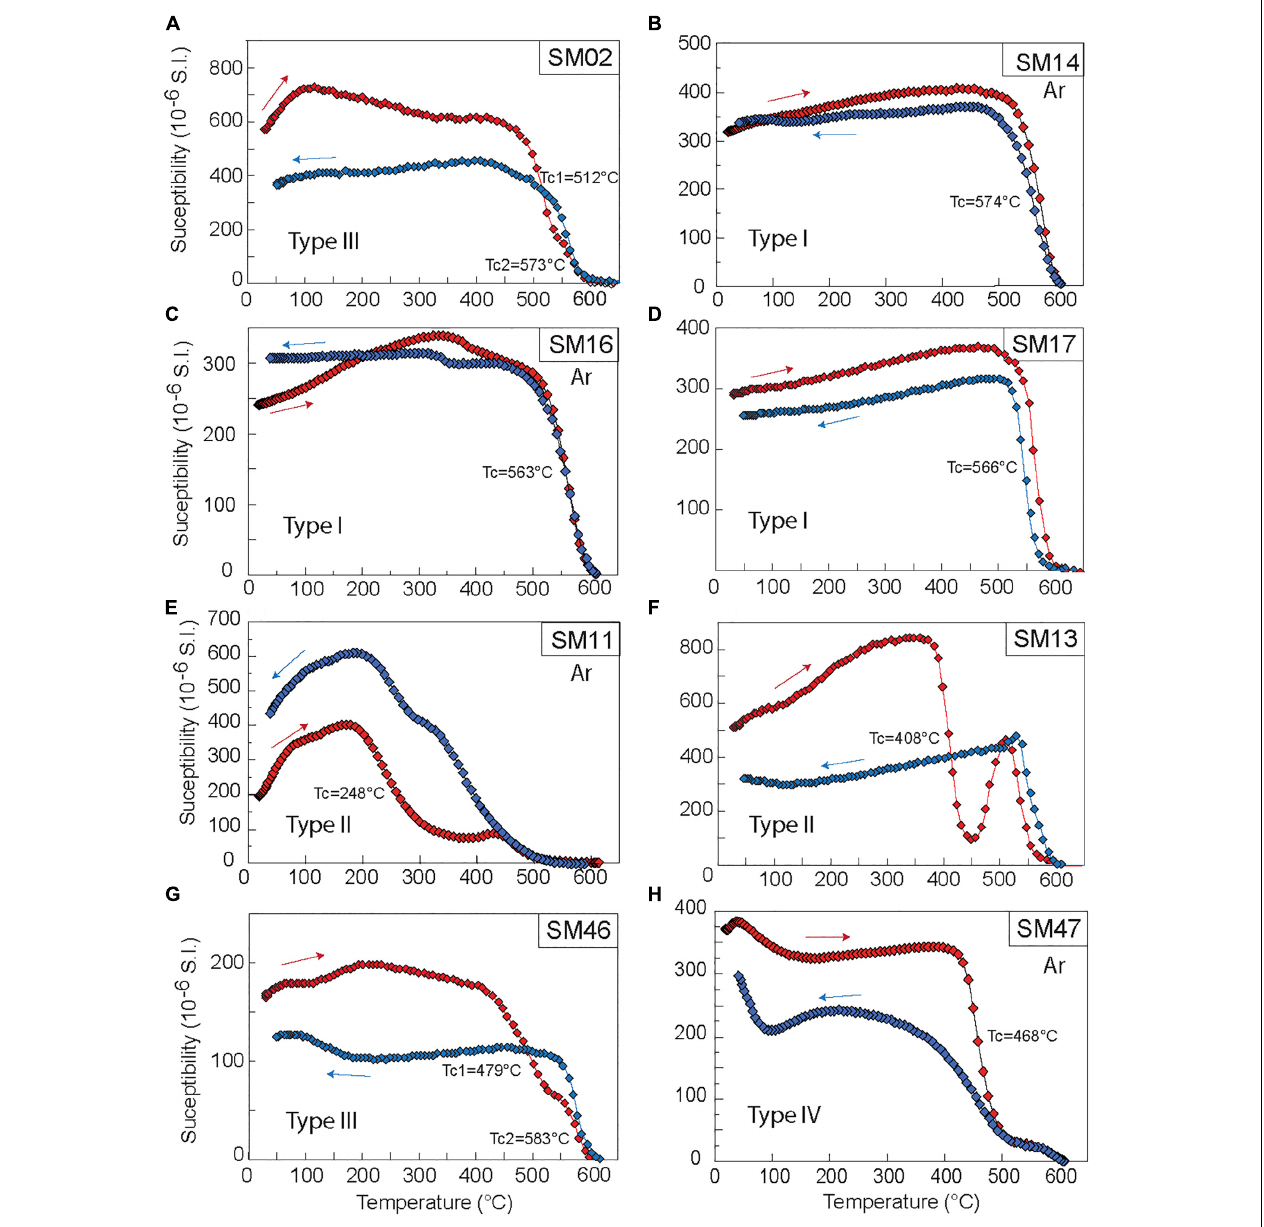
FIGURE 2 | (A–H) Magnetic susceptibility versus temperature (red and blue curves for heating and cooling, respectively) of 8 representative samples. The Curie temperatures corresponding to the inflection point during the decrease in susceptibility is given for each sample. Ar is for experiments under Argon atmosphere. Type I is for samples showing Tc around 550–580 ◦ C with broadly reversible behavior indicating low-Ti titanomagnetite and magnetite, Type II is for samples with titanomagnetite and titanomaghemite with irreversible behavior. Type III is for samples with a mixing of titanomagnetite with various amount of Ti causing Tc below 550 ◦ C, Type IV is for SM47 showing marked irreversibility with lower Tc during the cooling leg compared to heating